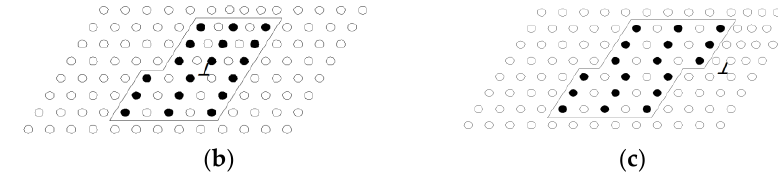
Figure 7. Schematic summary of dislocation cutting through precipitate: ( a ) initial stage of dislocation cut, ( b ) middle stage of dislocation cut, ( c ) and final stage of dislocation cut.